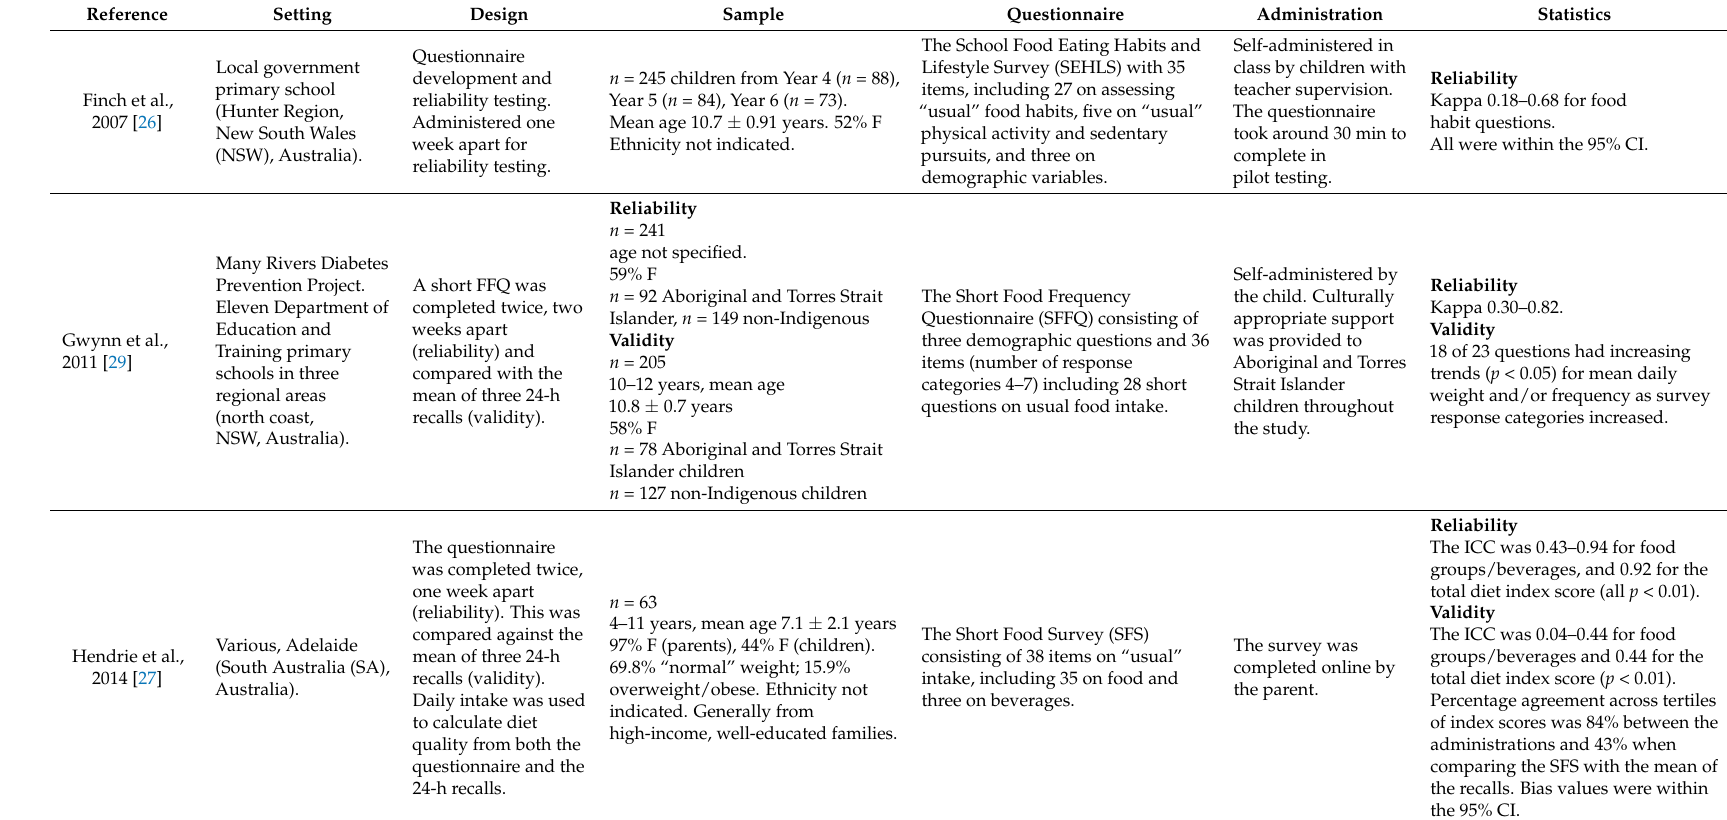
Table 1. Diet questionnaires included in the review from peer-reviewed journal articles